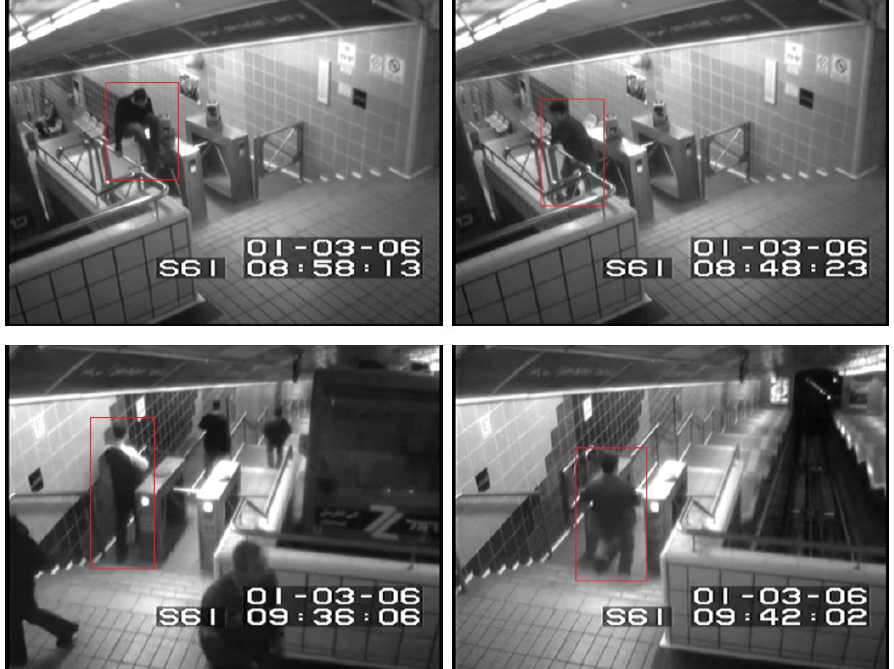
Figure 2. Examples of abnormal frames from the Subway dataset are presented. Abnormal frames are shown in the first row from the Subway Entrance, and abnormal frames are shown in the second row from the Subway Exit